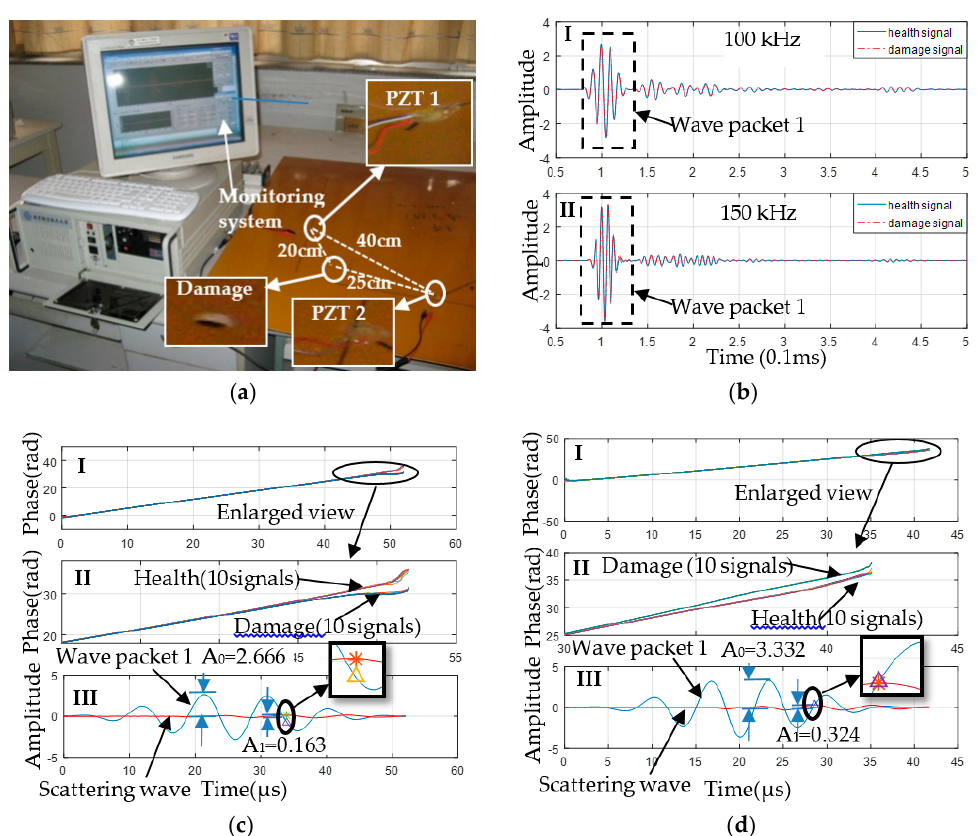
Figure 4. The sensing signal and the instantaneous phase in the active Lamb wave-based monitoring of the epoxy glass fiber plate structure. ( a ) Experimental setup for the active Lamb wave-based monitoring of the epoxy glass fiber plate. ( b ) Sensing signal of the active Lamb wave-based monitoring, and subfigures ( I , II ) show the response of the plate structure excited by the signal with the center frequency of 100 kHz and 150 kHz, respectively; ( c ) The monitoring signal with a center frequency of 100 kHz and the instantaneous phase, and subfigure ( I ) shows the instantaneous phase change, subfigure ( II ) denotes a locally enlarged view of ( II) , and subfigure ( III ) shows some information for the monitoring signal. ( d ) The monitoring signal with a center frequency of 150 kHz and the instantaneous phase. The explanation of the subfigures ( I – III ) is the same as ( c ). The instantaneous phase analysis is shown in Figure 4c,d with a center frequency of 100 kHz and 150 kHz, respectively. In Figure 4c,d, subfigure I presents the instantaneous phase of 10 monitoring signals after damage and 10 monitoring signals before damage; subfigure II denotes the locally enlarged view of subfigure I; subfigure III shows the information for the monitoring wave. As shown in Figure 4c,dII, the instantaneous phase of the 10 damage signals presented the same change concerning the instantaneous phase of 10 health signals, which indicates that the change was caused by a specific cause rather than a random signal. This change indicates that the monitoring signal was mixed with the scattering wave, and then it can be inferred that there was damage in the propagation damage diagnosis result obtained from the instantaneous phase change was consistent with the actual situation of the plate. According to Figure 4c,dIII, the direction and deformation of the instantaneous phase after damage could be obtained. In Figure 4cII, the instantaneous phase after the damage was smaller than the original instantaneous phase. According to the relationship between the superposition site and the direction of the instantaneous phase change obtained in Section 3.2, the superposition site of the scattering wave should be between the maximum and minimum of the direct wave. The real scattering wave and direct wave were used to verify this inference. In Figure 4cIII, the Wave packet of the direct wave is labeled “Wave packet 1”, and the damage scattering wave is labeled as “Scattering wave.” According to the definition of the superposition site in Section 3.2, the maximum point of the “Scattering wave” is marked as “*”, and the intersection point between the projection of this maximum “*” point on the abscissa, and the direct wave is the superposition site, which is marked as “ ∆ ”. The local magnification in Figure 4cIII shows that “ ∆ ” is indeed between the maximum and minimum of the direct wave. In Figure 4dIII, based on the same processing and analysis, the instantaneous phase after the damage is larger than the original phase, and the superposition position of scattering wave should be between the minimum and maximum. The local magnification in Figure 4dIII shows that “ ∆ ” is indeed between the minimum and maximum of the direct wave. The instantaneous phase analysis results of the two experiments are consistent with the relation between the instantaneous phase change direction and the scattering wave superposition summarized in Section 3.2. The instantaneous phases are shown in Figure 4cII,4dII, and their deformation degree is different from the original instantaneous phase shape. From the analysis of the